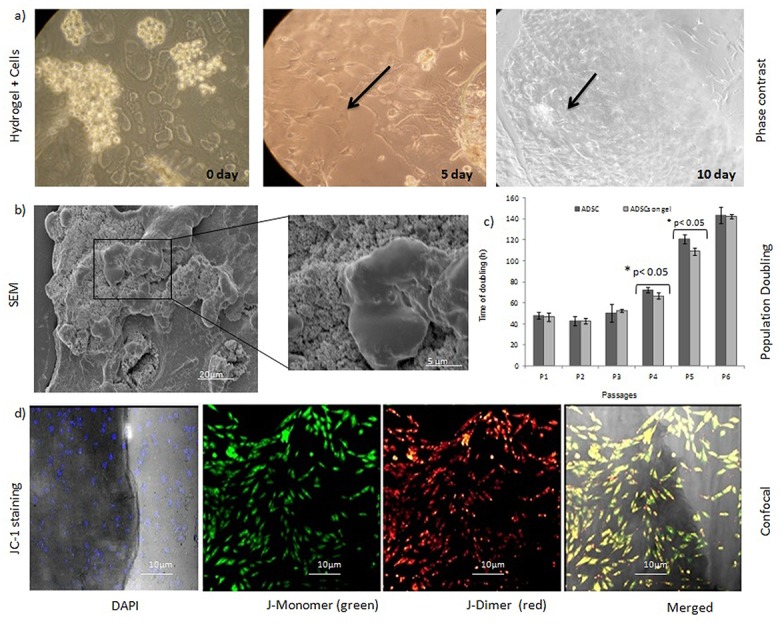
Proliferation potential of hADSCs on chitosan hydrogel.a) hADSCs cultured on chitosan hydrogel on different days. Magnification 200X. b) SEM imaging revealed uniform distribution of hADSCs on the hydrogel. Further, the cells were growing in close association with the hydrogel. c) The mean ± SD values for PDT were low when cells were grown on a hydrogel matrix. There was a significant difference in growth rates of the hADSCs on the hydrogel matrix at P <0.05 (n = 3). d) JC-1 staining showed JC-1 dimer formation within the stem cell network, thereby indicating the presence of metabolically active live cells on the hydrogel using CLSM. The JC-1 staining of cells differentiate dead from viable intact cells by their mitochondrial membrane integrity. The negative charge established by the intact mitochondrial membrane potential allows the lipophilic dye, to enter the mitochondrial matrix where it accumulates. When the critical concentration is exceeded, J-aggregates form, which appear as fluorescent orange. In non-viable cells, the mitochondrial membrane potential collapses, and the JC-1 cannot accumulate within the mitochondria. The bright field image shows actively growing stem cells present in the hydrogel (n = 3).